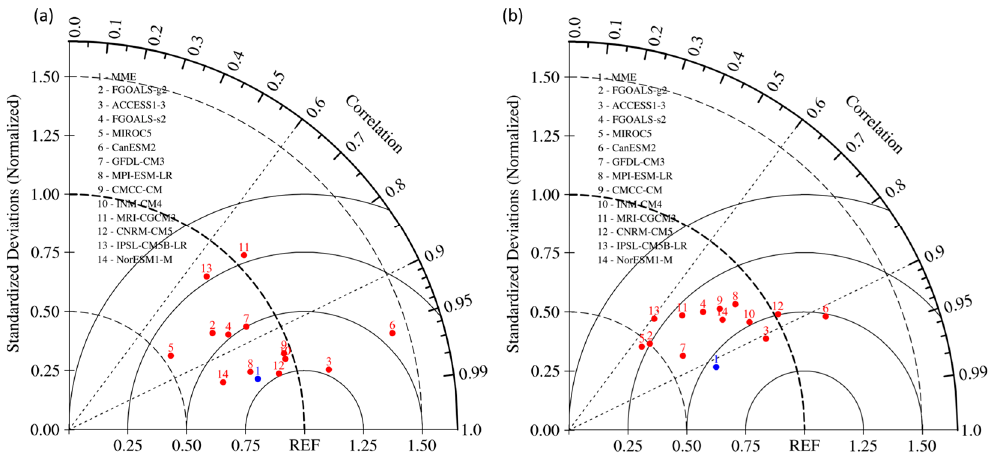
Figure 2. Taylor diagrams of ( a ) WNPST Climatology and ( b ) interannual variation of its amplitude.